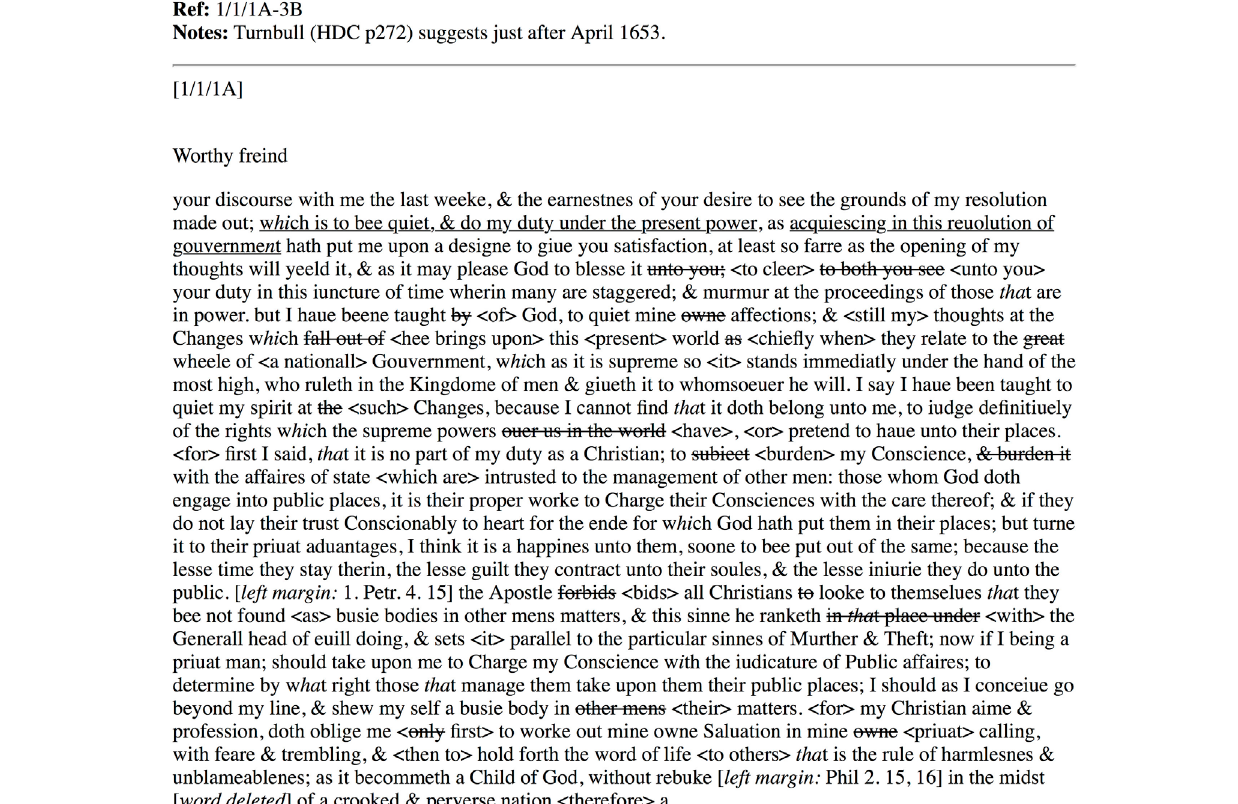
5 Frontiers in Digital Humanities |